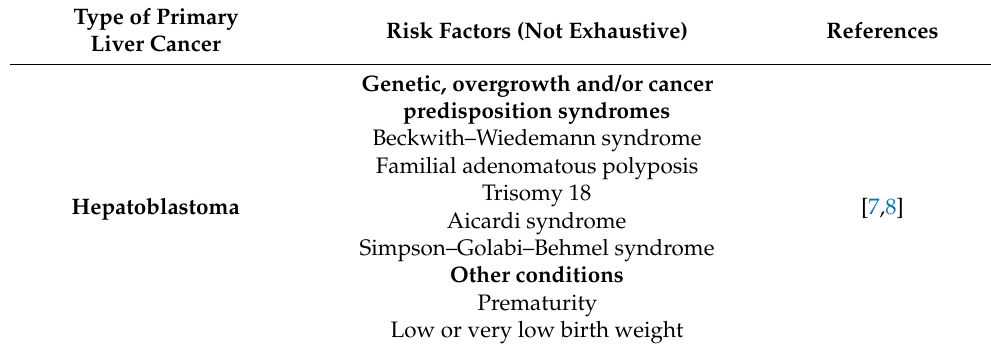
Table 1. Risk factors for hepatoblastoma and HCC in children [7–9,18–39]. Type of